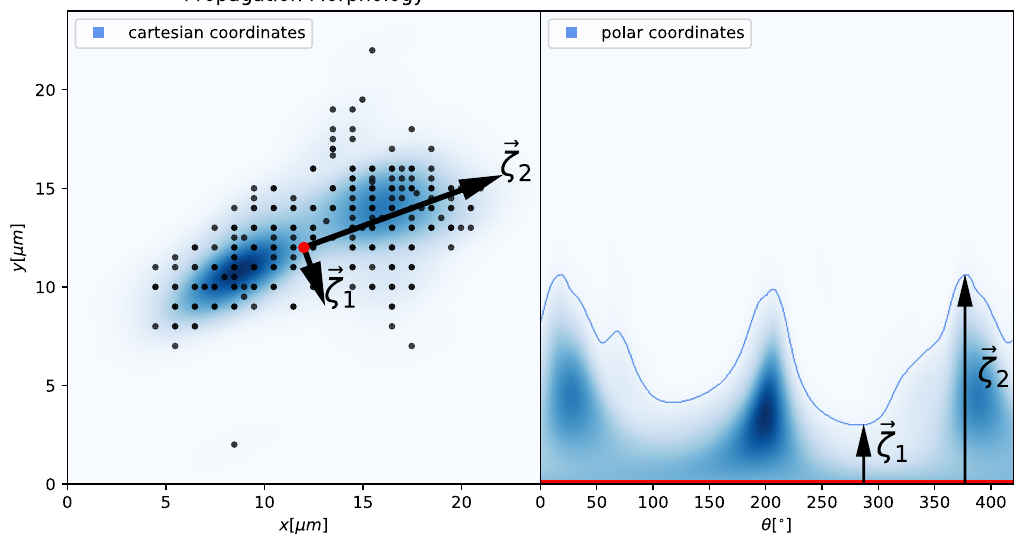
Figure 11. Cell propagation morphology in cartesian coordinates (left) and polar coordinates (right). Time- dependent cell vertices (cid:31) C ( x , y , t ) (black dots) and their spatial density distribution (blue). The vectors ζ 1 and ζ 2 are the independent basis vectors used to characterize the eccentricity of the spatial density distribution of C ( x , y , t ) (cid:31)